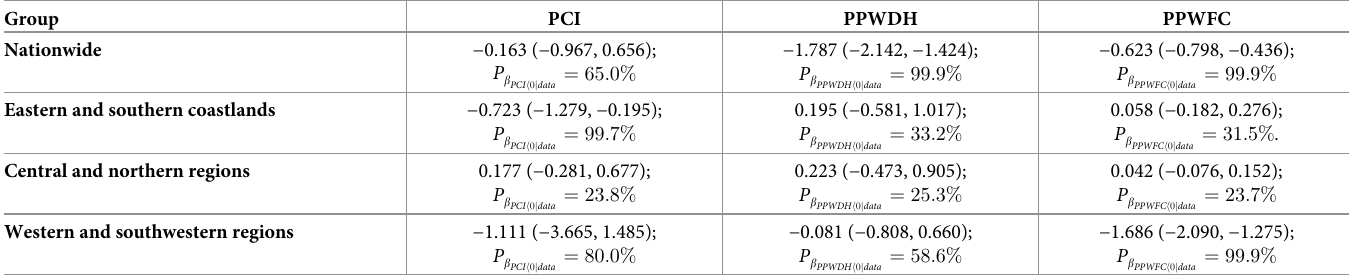
Table 2. Overall regression parameters and subnational regression parameters of the 3 variables in China’s eastern and southern coastlands, central and northern regions, and western and southwestern regions, with a 95% CI, estimated by posterior means of the Bayesian multivariable regression model. Group PCI PPWDH PPWFC